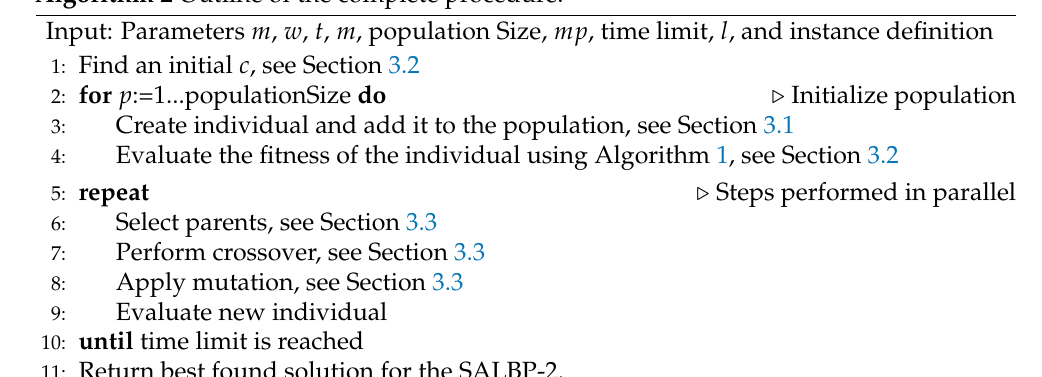
Algorithm 2 Outline of the complete